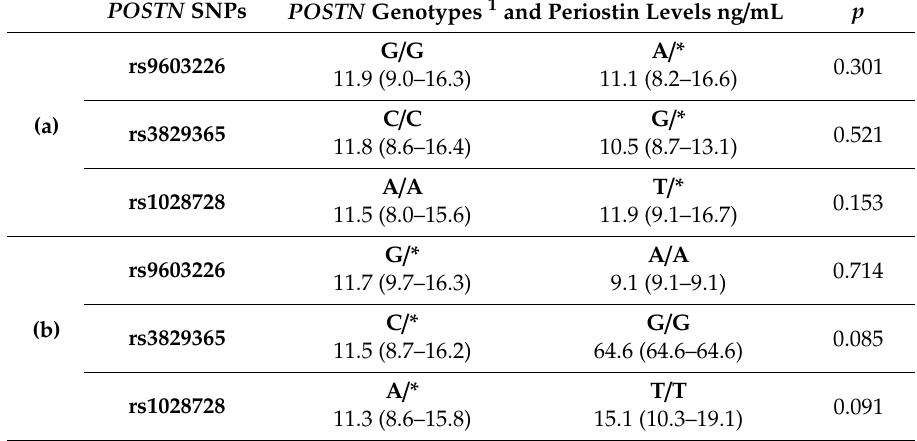
Table 7. Periostin levels as a function of POSTN gene SNPs in NAFLD and HCV patients (N. = 155), see text for details. Median and interquartile range are reported. The p value refers to the di ff erences of periostin plasma levels between the various POSTN genotypes. (a): dominant model (MM versus Mm + mm). (b): recessive model (MM + Mm versus mm). * = any of the two possible nucleotides for each of the conditions of interest. POSTN SNPs POSTN Genotypes 1 and Periostin Levels ng /